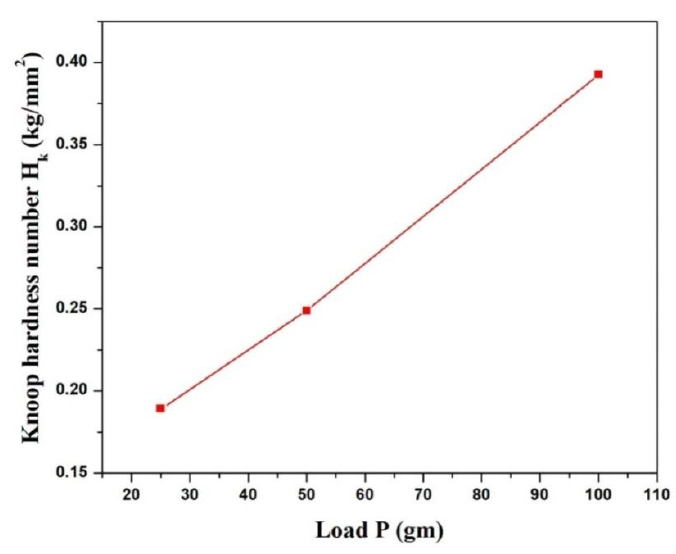
Figure 12. Load P with Knoop hardness number. Table 6. Calculated Knoop hardness number for different loads of UGA.